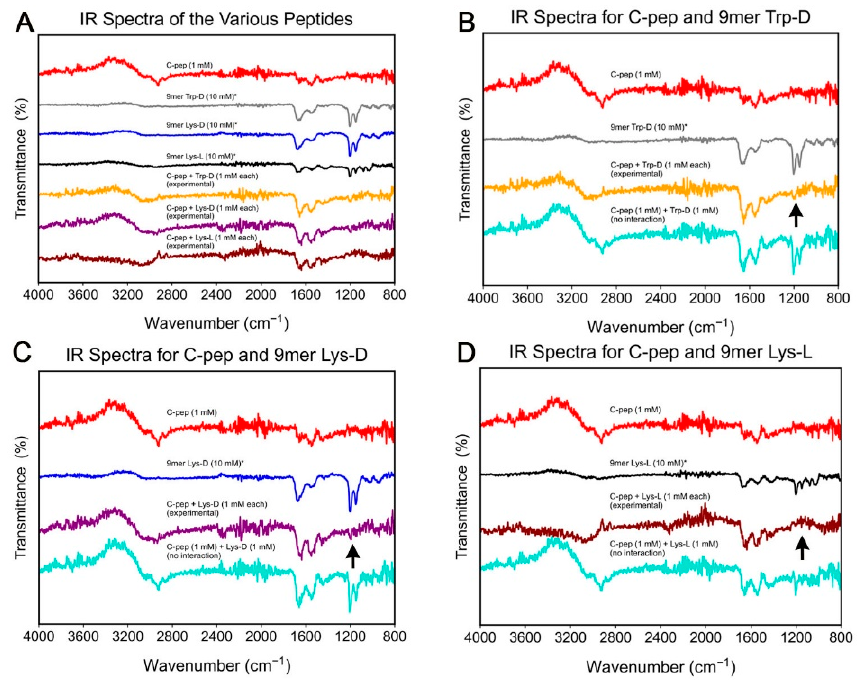
Figure 6. ATR-FTIR spectra of C-peptide, Trp-D, Lys-D, and Lys-L. Panel ( A ) compares and contrasts the IR spectra of C-peptide, 9mer com-peptides, and the mixtures. Panels ( B – D ) compare the experimental IR spectra of C-peptide+com-peptide with the theoretical spectrum, C-peptide and the respective com-peptide. The arrows in spectra ( B – D ) indicate the main difference between the experimental and theoretical spectra. The disappearance of the peaks around 1200 cm − 1 suggests that there is interaction of Trp with C-peptide during co-assembly. The bump around 3300 cm − 1 is due to imperfect subtraction of the background water stretching mode.